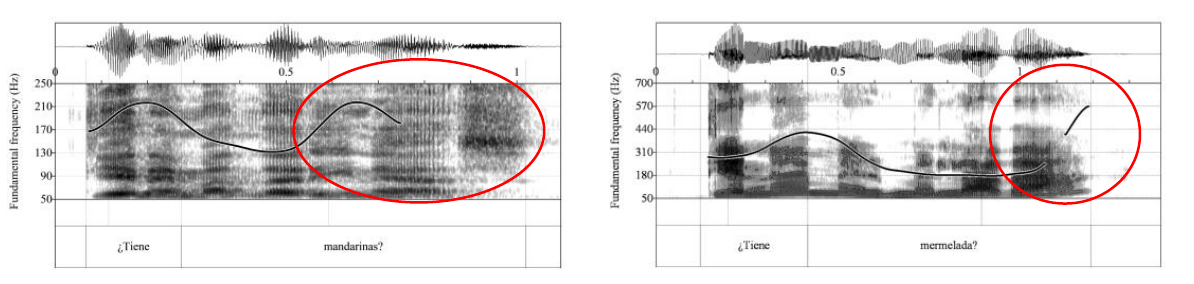
Source : Interactive Atlas of Romance Intonation (Prieto et al.